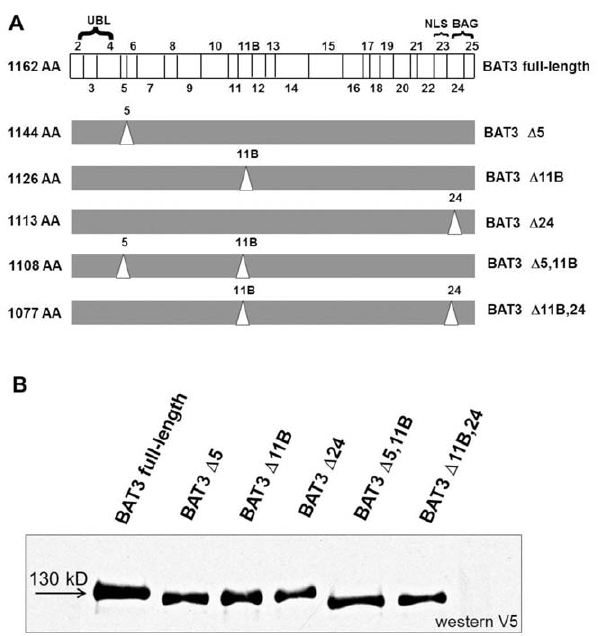
Figure 3. Identification of BAT3 splice variants. A. Schematic presentation of BAT3 variants. BAT3 full-length containing exons 2 to 25 is shown on top (translation starts with exon 2). Identified BAT3 variants with deleted sequences are shown below. Deleted exons are indicated by triangles. Designation of the variants is shown on the right and the calculated number of amino acids (AA) of the BAT3 proteins is indicated on the left. UBL: ubiquitin-like domain, NLS: nuclear localization signal, BAG: Bcl-2 associated athanogene-domain, B. Expression of BAT3 isoforms. COS-7 cells were transfected with V5-tagged BAT3 cDNAs, lysed, separated by SDS-PAGE and immunoblotted for BAT3 with anti V5 antibody. BAT3 variants are indicated on the top and a molecular weight marker is shown on the left. Compared to the full length BAT3 with a molecular weight of about 130 kDa, the calculated sizes of the variants are the following: BAT3 D 5 (128 kDa), BAT3 D 11b (127 kDa), BAT3 D 24 (125 kDa), BAT3 D 5, 11b (125 kDa) and BAT3 D 11b, 24 (122